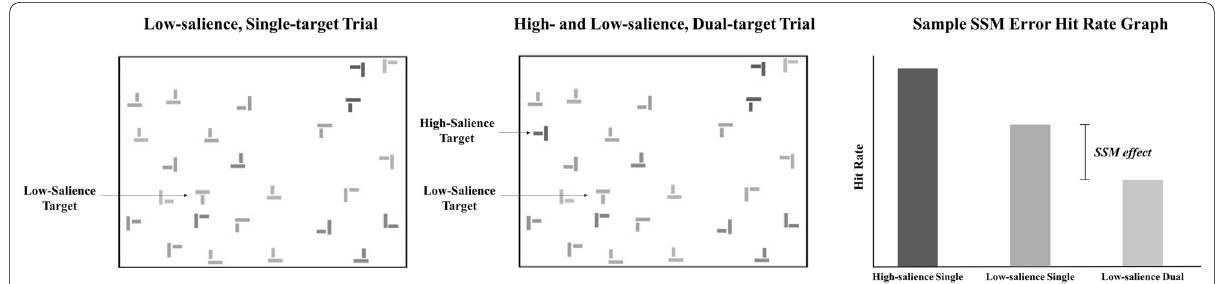
Fig. 1 Sample Single-target Display, Dual-target Display, and Hit Rate Graph for an SSM task: In a standard cognitive science SSM task, observers are asked to search in simplified-search displays for ‘T’ shaped targets (where the crossbars of the two perpendicular rectangles perfectly bisect one another) amongst pseudo ‘L’ shaped distractors (two perpendicular rectangles do not perfectly bisect one another). Search items are typically randomized for rotation (e.g., 0, 90, 180, or 270 from a canonical ‘T’ shape) and location within the search display. Search items may also vary in “salience” (e.g., a darker gray or light gray color amongst a white background), which allows researchers to compare the hit rate of a specific type of target (e.g., low-salience ‘T’) between single and dual-target displays to calculate the SSM effect. The graph above depicts a typical SSM effect with a lower hit rate for a low-salience ‘T’ when it appeared in a dual-target display compared to when a low-salience ‘T’ appeared in a single-target display. These hypothetical results suggest that the detection of the low-salience target ‘T’ was affected by the detection of the high-salience target ‘T’ compared to when it was by itself in a search display (e.g., Fleck et al.,